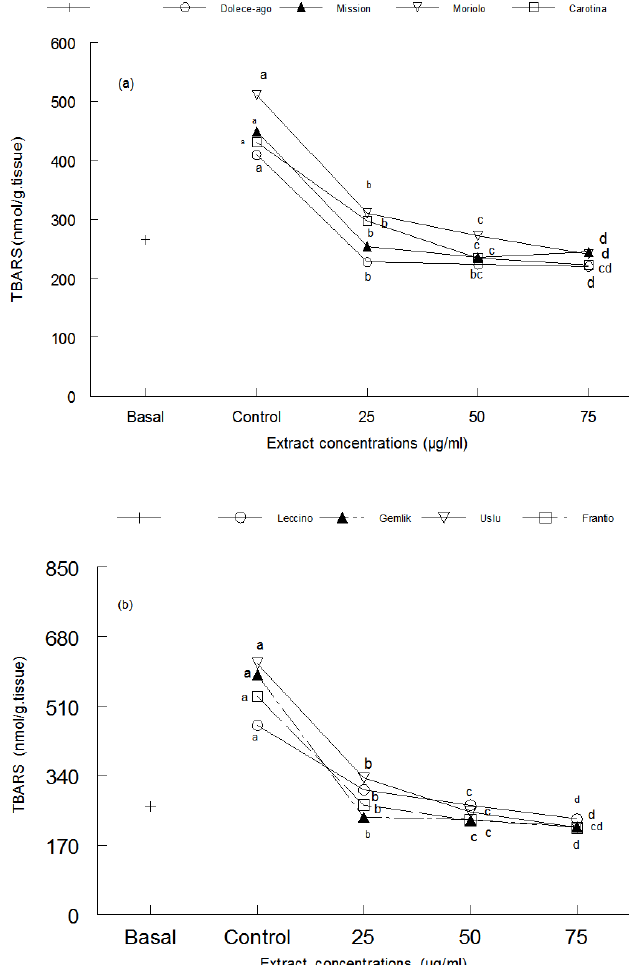
Fig. 1: The inhibitory effect of aqueous extract of eight cultivars of olive on iron sulphate induced lipid peroxidation in mice liver. The results are means of three separate experiments ± SD. P < 0.05 is significantly different from control by DMR test. All the values are significantly different (P < 0.05) from control by DMR test.